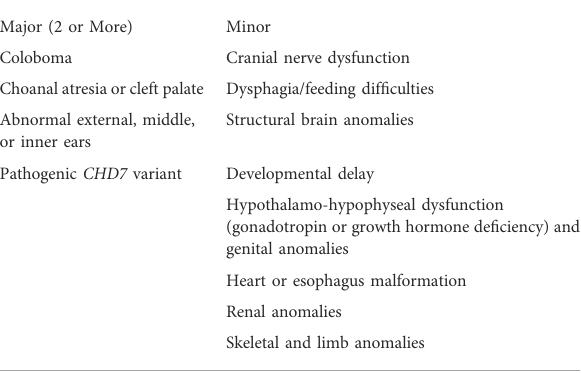
TABLE 2 CHARGE syndrome diagnostic criteria.